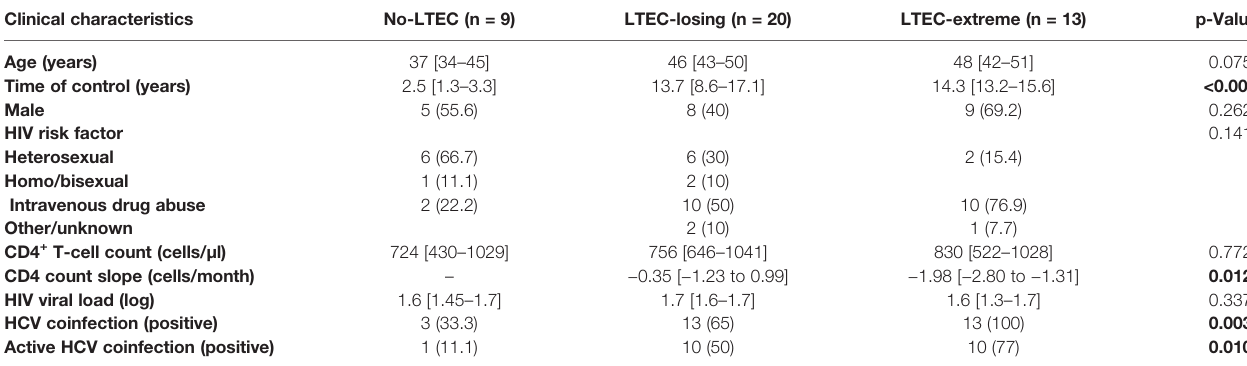
TABLE 1 | Baseline characteristics of the study participants.